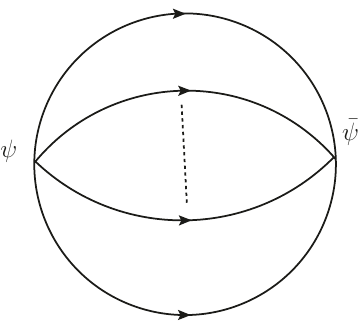
Figure 2 . Single loop contribution to free